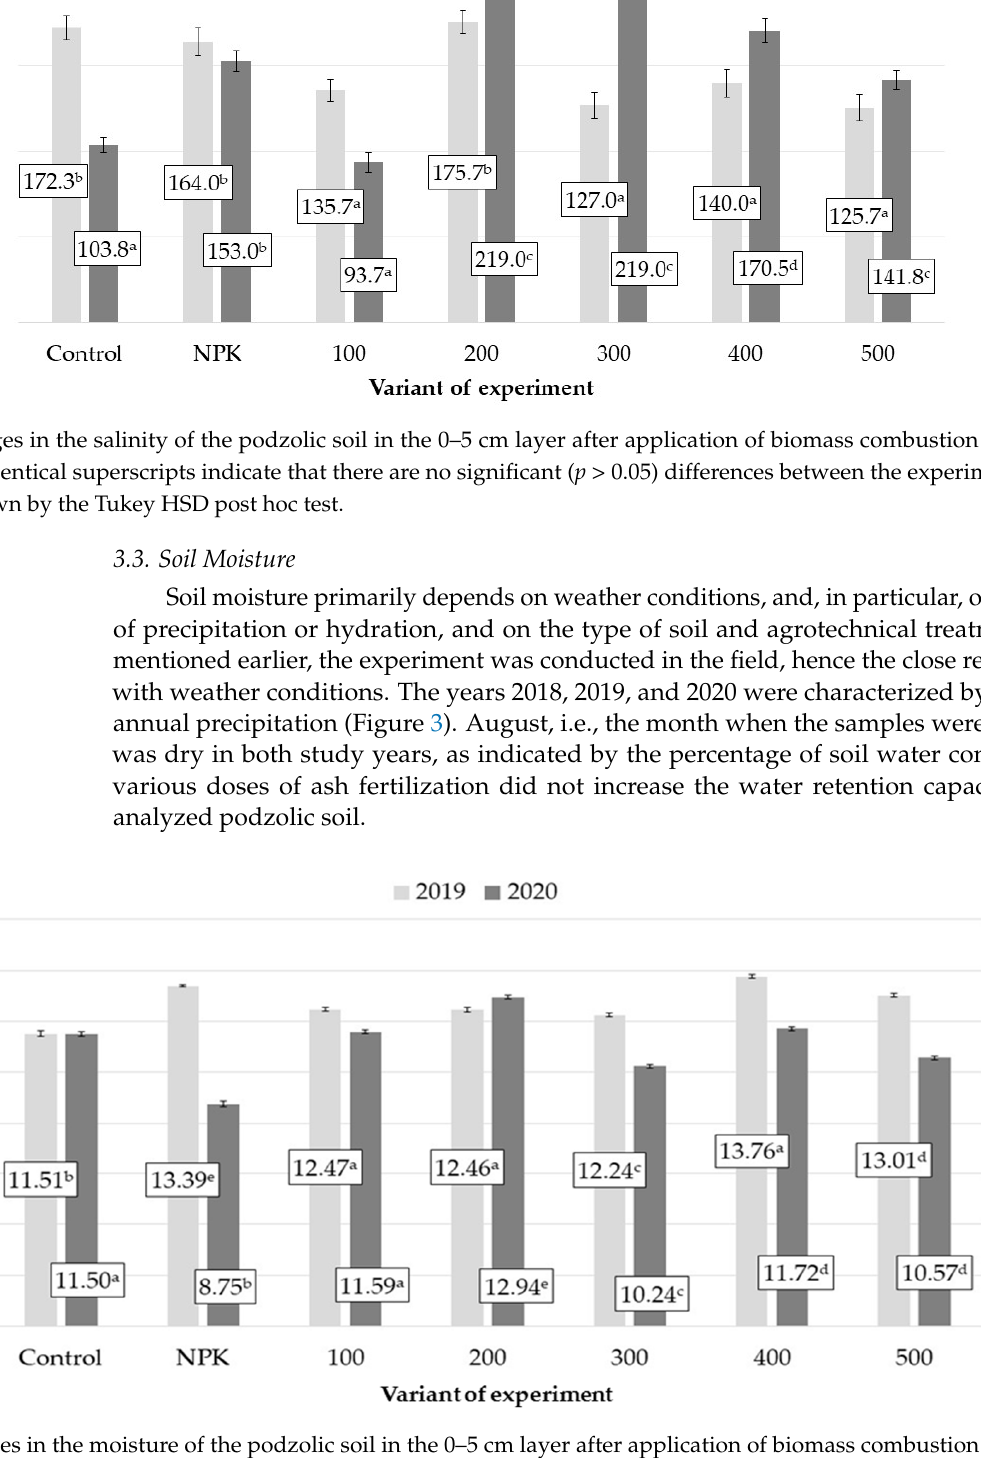
Figure 3. Changes in the moisture of the podzolic soil in the 0–5 cm layer after application of biomass combustion ashes (mean ± SD). Identical superscripts indicate that there are no significant ( p > 0.05) differences between the experimental variants, as shown by the Tukey HSD post hoc test.